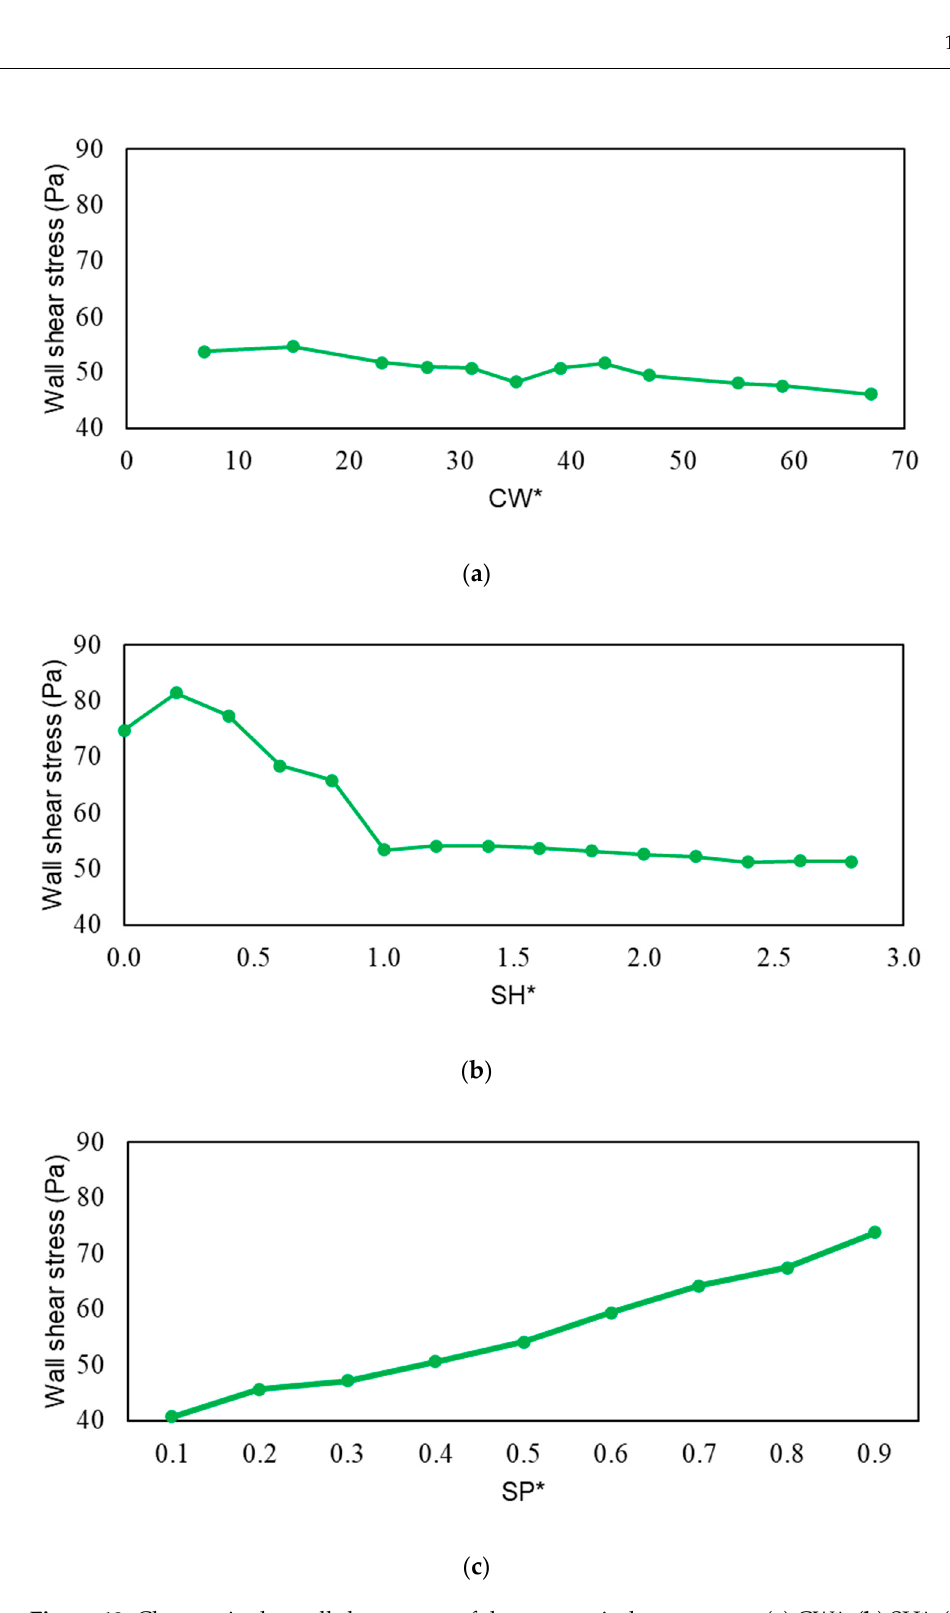
Figure 13. Changes in the wall shear stress of the geometrical parameters. ( a ) CW*. ( b ) SH*. ( c ) SP*.